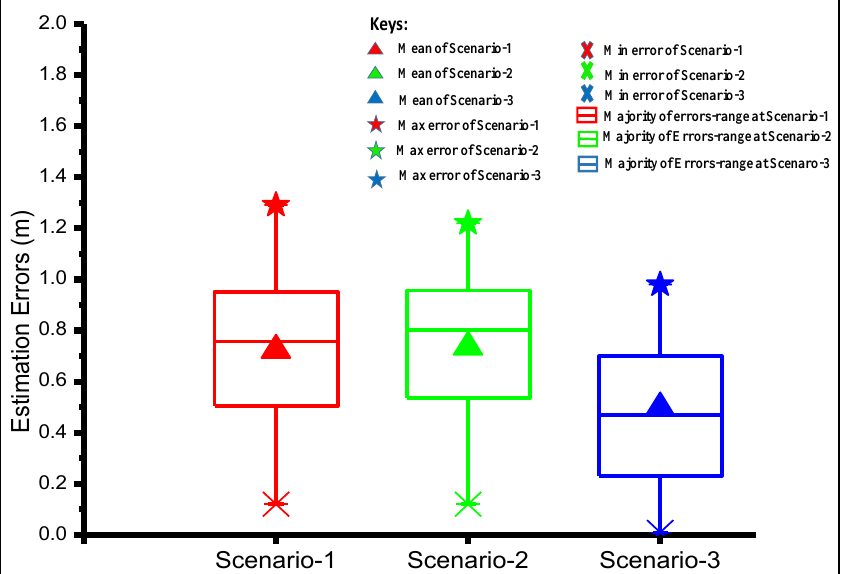
Figure 4. Multilayer perceptron (MLP) localization performance in different scenarios.